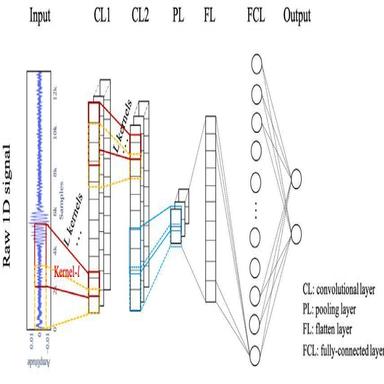
Architecture of 1DCNN with basic convolutional, pooling, and fully-connected layer.